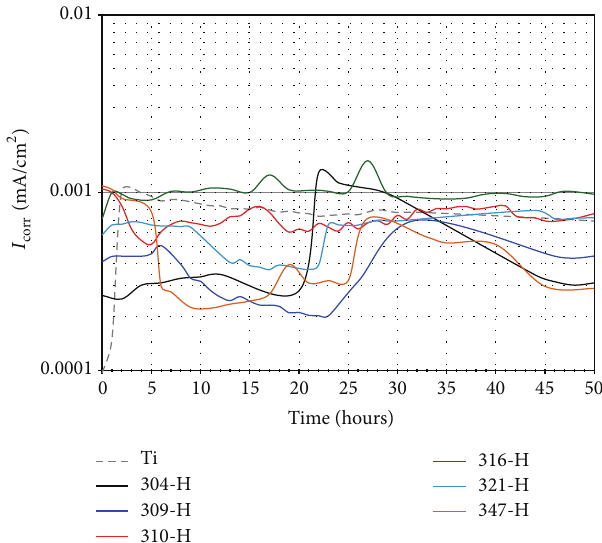
Figure 10: Change of 𝐼 saliva at 37 ∘ C.